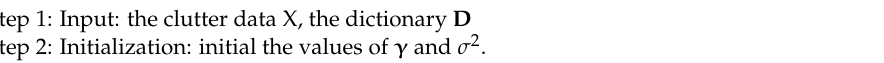
Algorithm 1: Pseudocode for the M-SBL-STAP